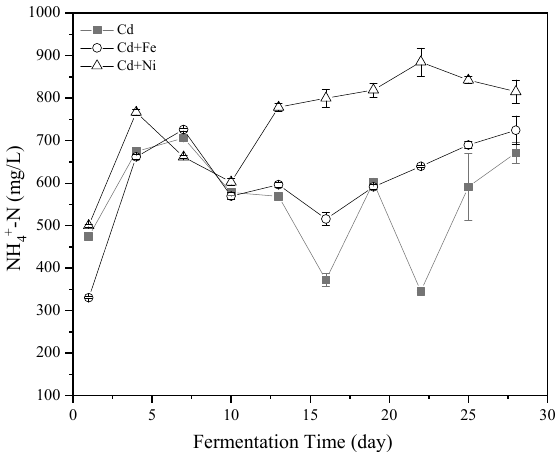
Figure 3. Impact of Cd, Cd + Fe, and Cd + Ni addition on NH 4 + –N concentrations during the fermentation.